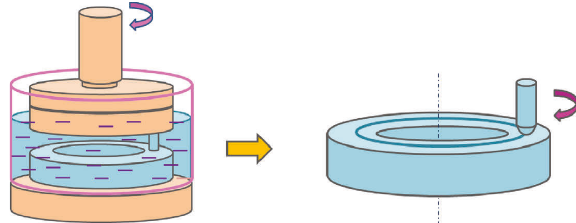
2 nanoparticles.